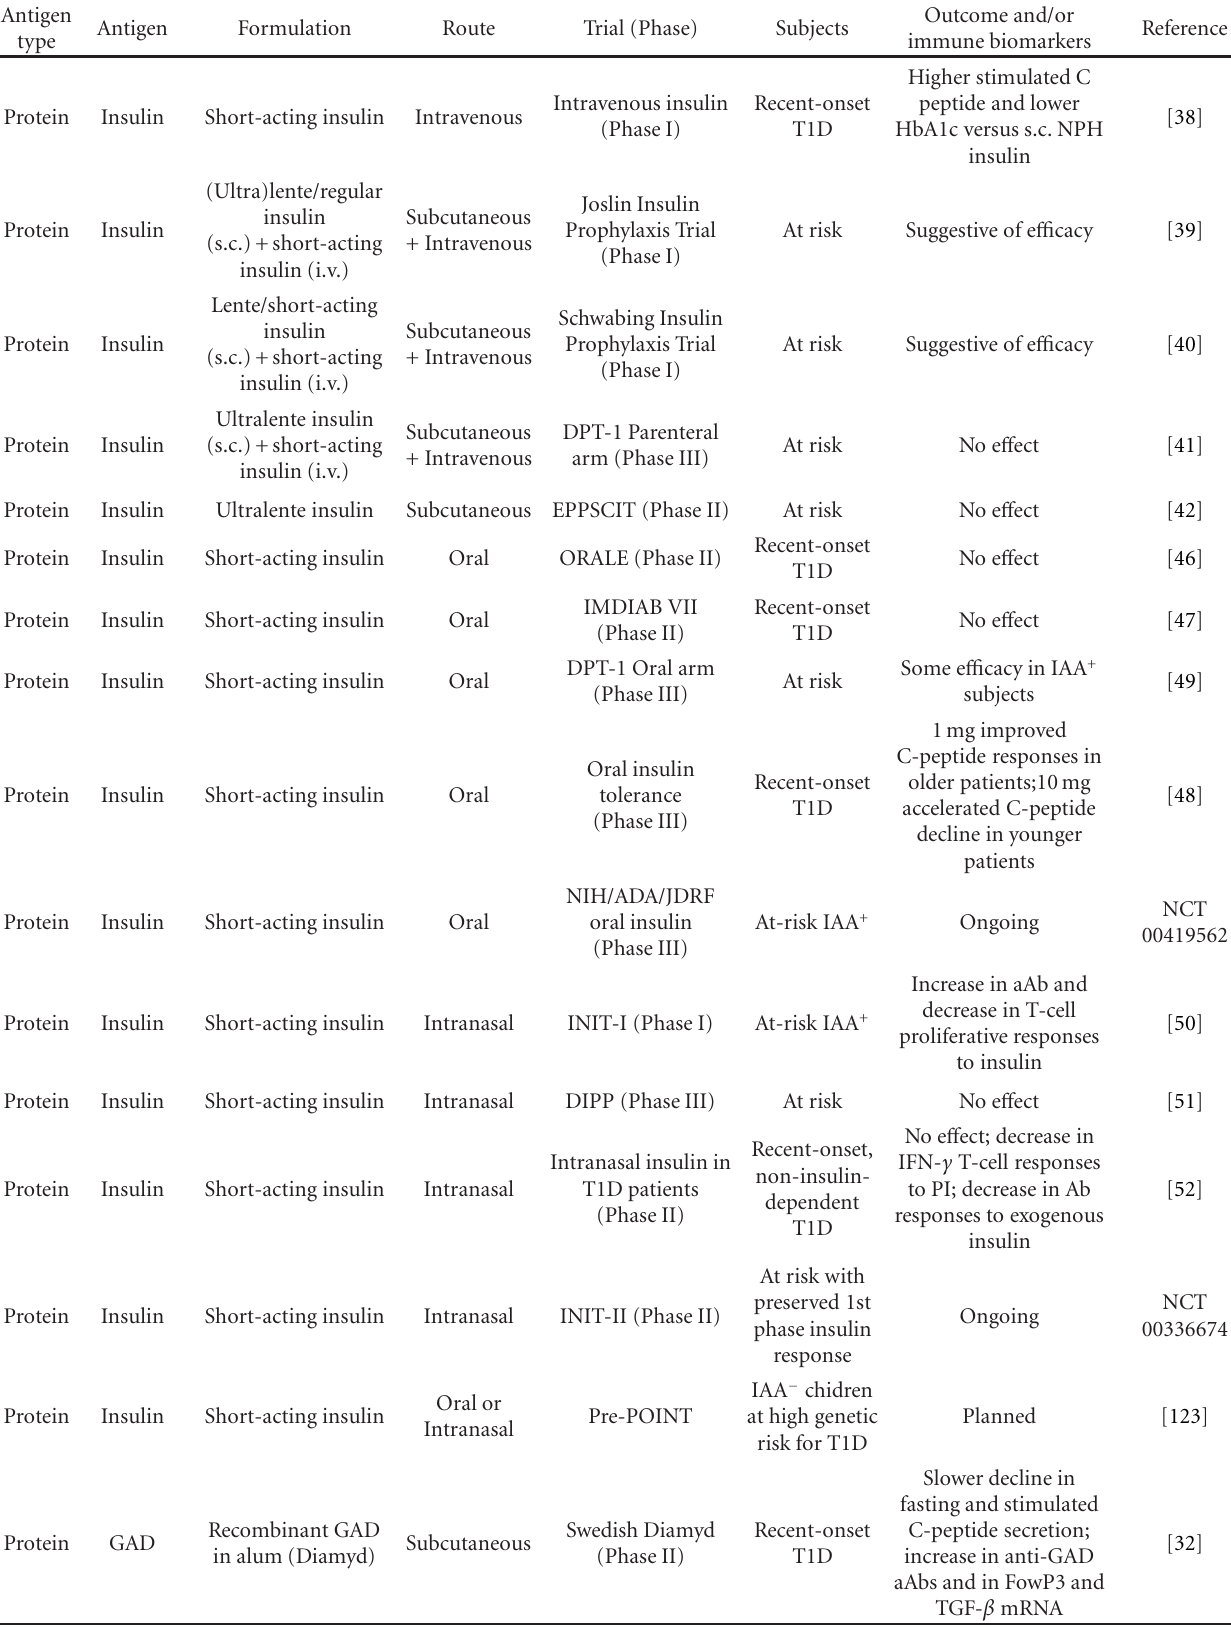
Table 1: Clinical trials in T1D using antigen-specific